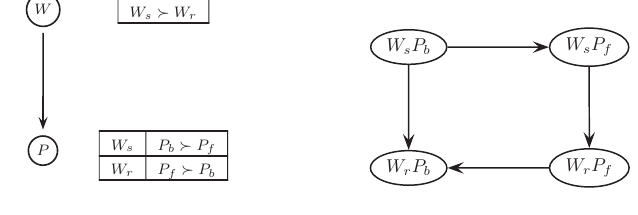
Figure 2. An example of CP-net named “My Weekend”.